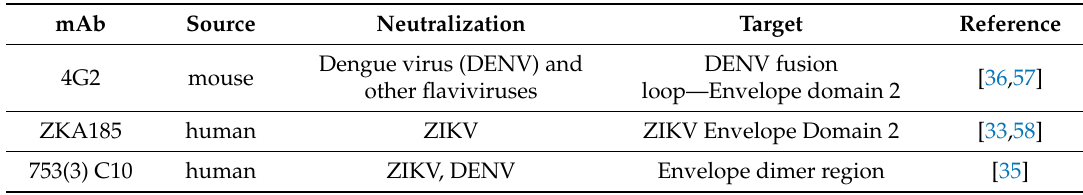
Table 3. Monoclonal antibodies used in this